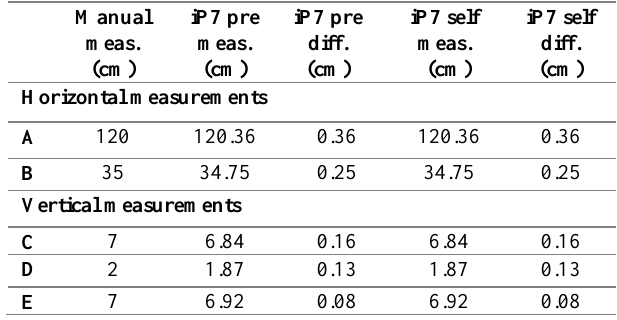
Table 2. Dimensions of curb ramp parameters of interest using 3D point cloud generated with full set of images from iPhone 7; pre-calibrated camera parameters vs self-calibration procedure.